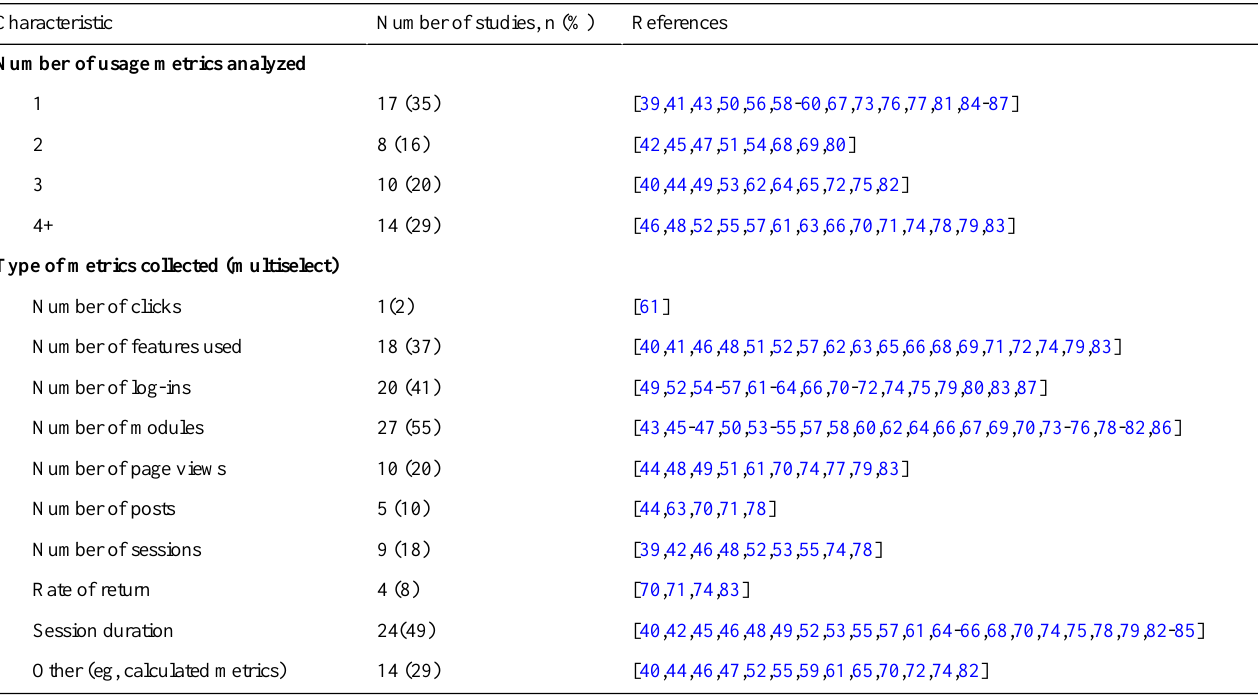
Table 2. Types of usage metrics collected in included studies (N=49). ReferencesNumber of studies, n